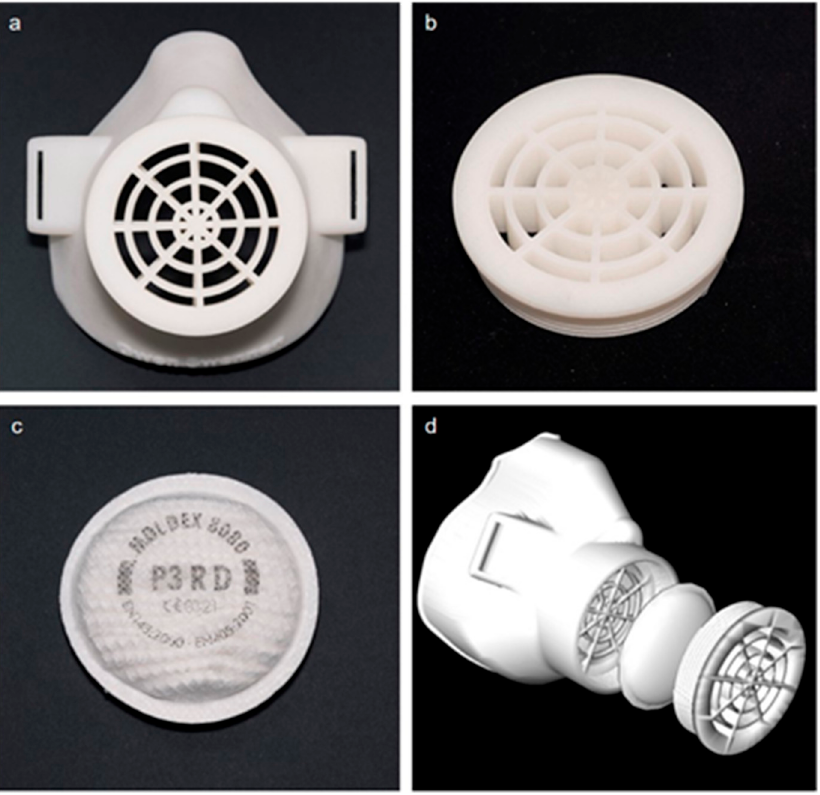
Figure 9. Custom made 3D protective face mask. ( a ) Reusable 3D-printed face mask, ( b ) filter membrane support, ( c ) filter membrane and ( d ) 3D image of the prototype.